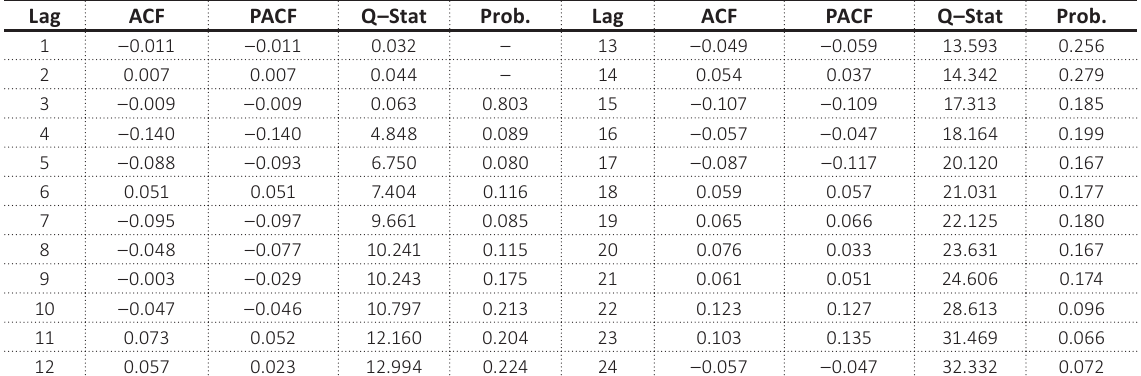
Table A3. Residuals’ ACF for (5-6)